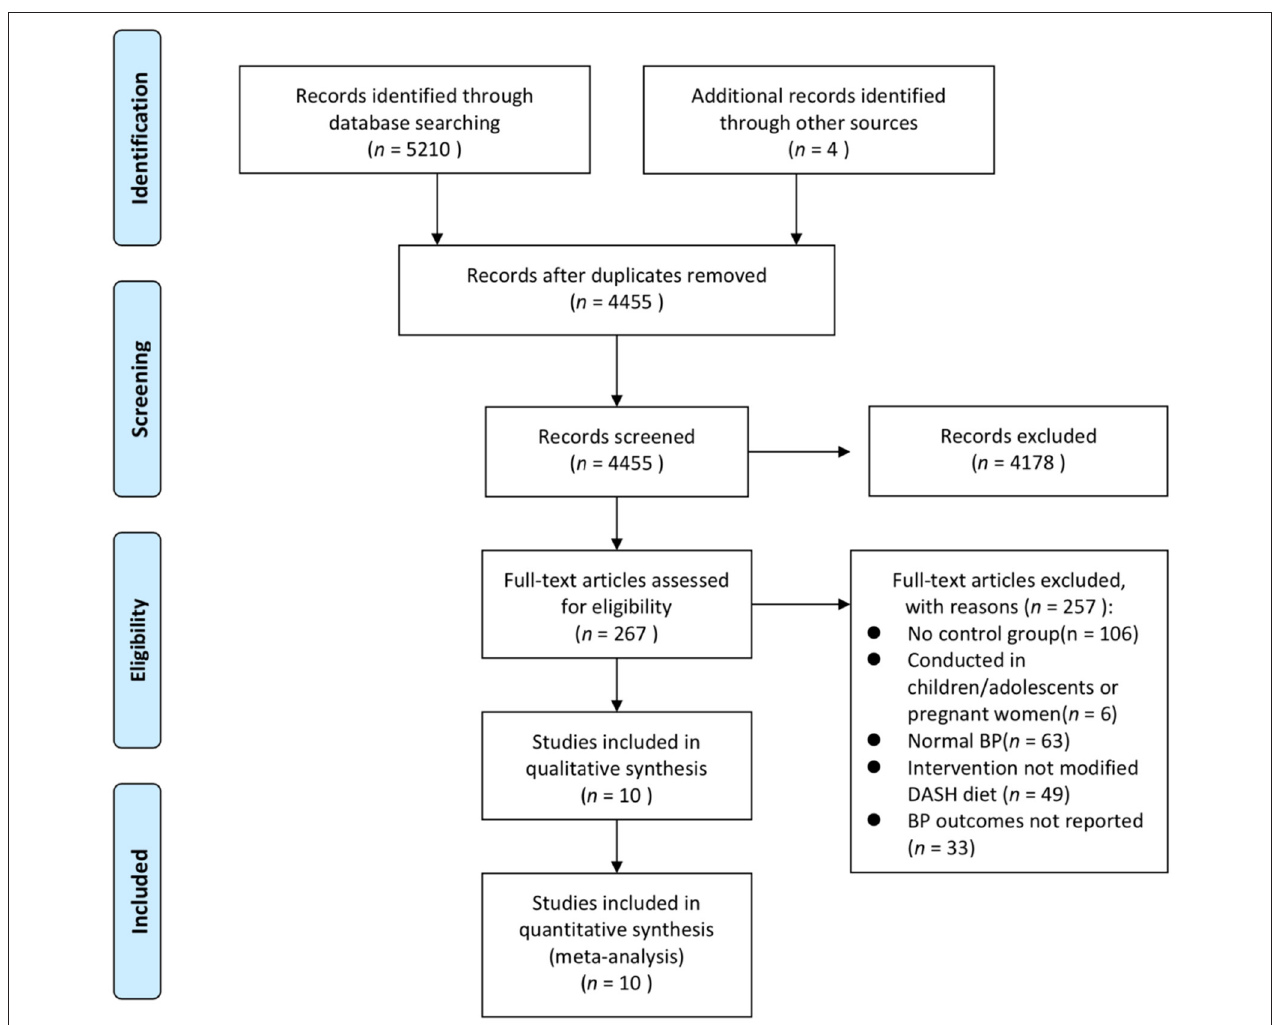
FIGURE 1 | PRISMA flowchart of the included studies. BP, blood pressure; DASH, Dietary Approaches to Stop Hypertension; RCT, randomized controlled trial.